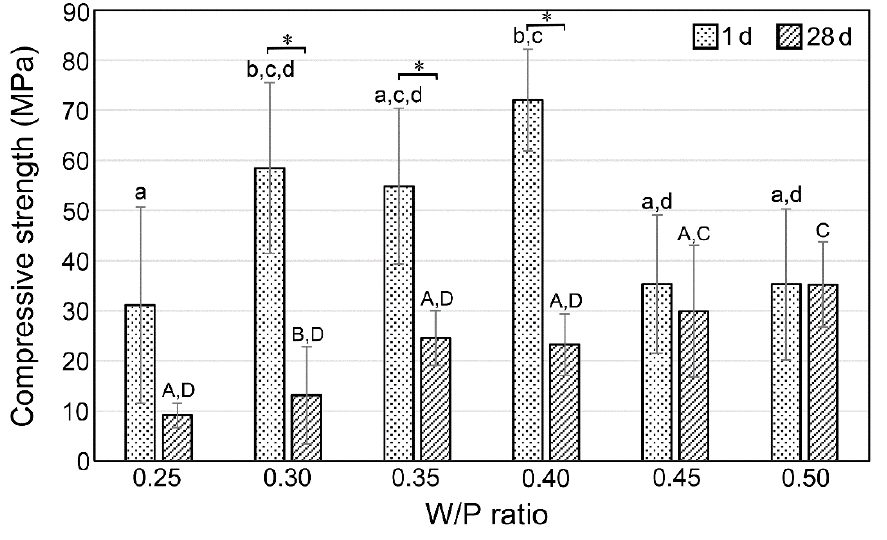
Figure 3. Compressive strengths of S 2 Ce cements after 1 d and 28 d from cement mixing. Columns with different letter(s) (lower case (a – d) for 1 d group and capitals (A – D) for 28 d group) are significantly different ( p < 0.05). Asterisk (*) represents significant differences between the 1 d and 28 d maturing periods of the samples with the same W/P ratio.